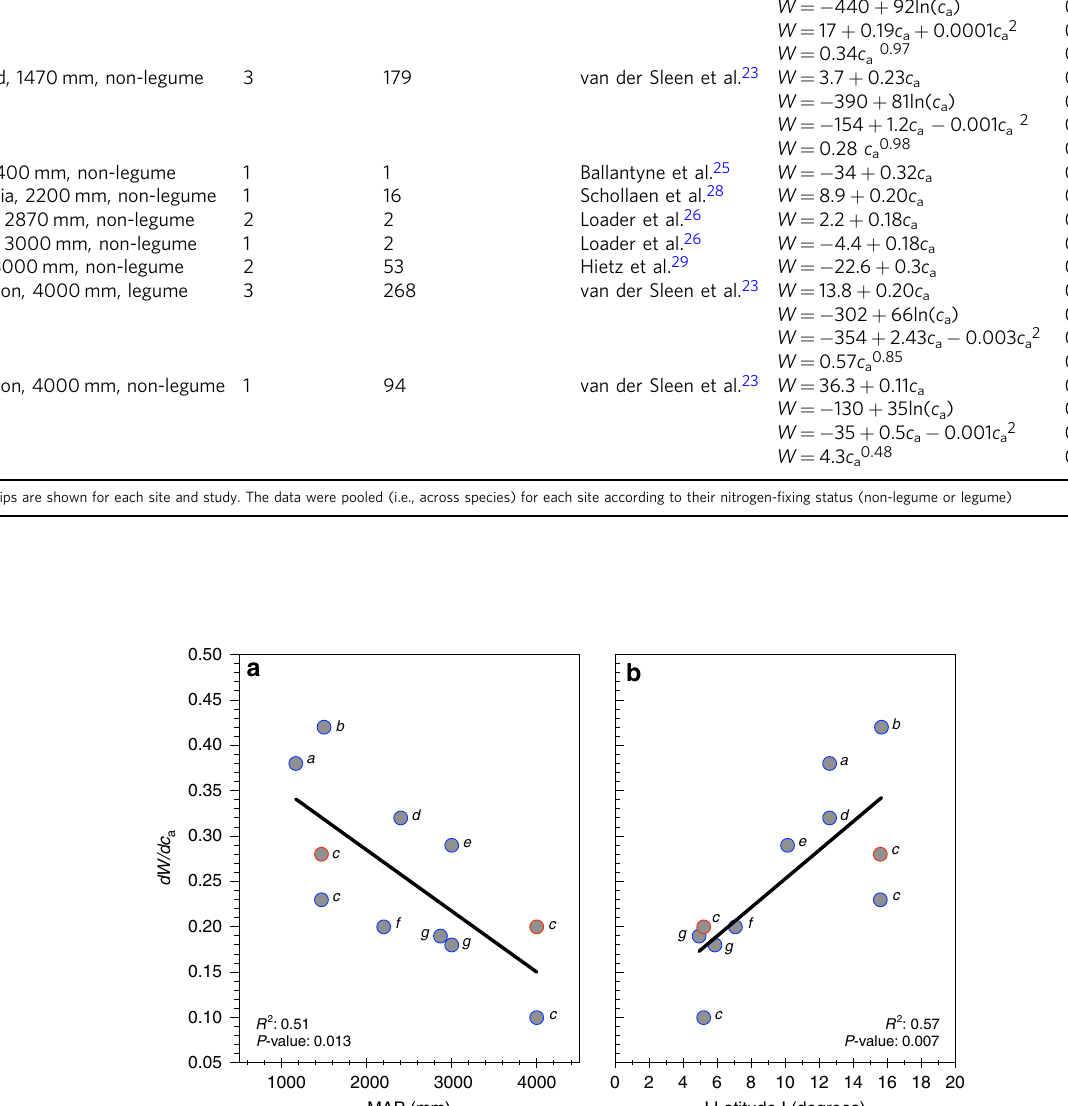
Fig. 1 Rainfall and latitude in fl uences on change in W per unit c a . a The relationship of dW/dc a (change in intrinsic water-use ef fi ciency ( W ) per unit atmospheric [CO 2 ] ( c a ); as derived from tree rings) to mean annual precipitation. b Relationship of dW/dc a to absolute latitude. The data are site averages of long-term isotope series (each spanning at least the period 1915 – 1995) for tropical biomes. Points marked in red in both ( a ) and ( b ) are the data for legumes. For both ( a ) and ( b ), data sources are : (a) Wils et al. 24 , (b) Nock et al. 27 , (c) van der Sleen et al. 23 , (d) Ballantyne et al. 25 , (e) Hietz et al. 29 , (f) Schollaen et al. 28 , (g) Loader et al.